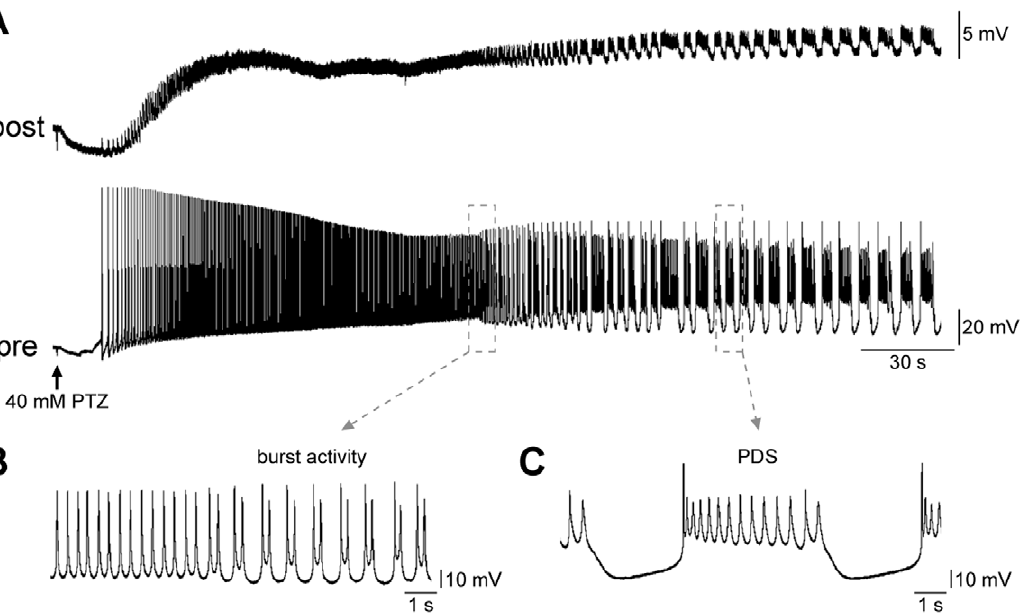
Figure 1. PTZ application induces epileptiform activity in Helix B2 – B2 monosynaptic connections. (A) Representative electrophysio- logical recording of PTZ-induced epileptiform activity from a B2–B2 connection in culture. EPSPs were recorded from the postsynaptic cell kept hyperpolarised to 30 mV below its membrane potential to prevent firing. The application of 40 mM PTZ rapidly generated sustained firing activity in the presynaptic neuron. Afterwards, the discharge pattern changed from single spikes to a burst firing pattern (B) and PDS episodes (C). PDS is an abnormal prolonged depolarisation step with superimposed action potentials.